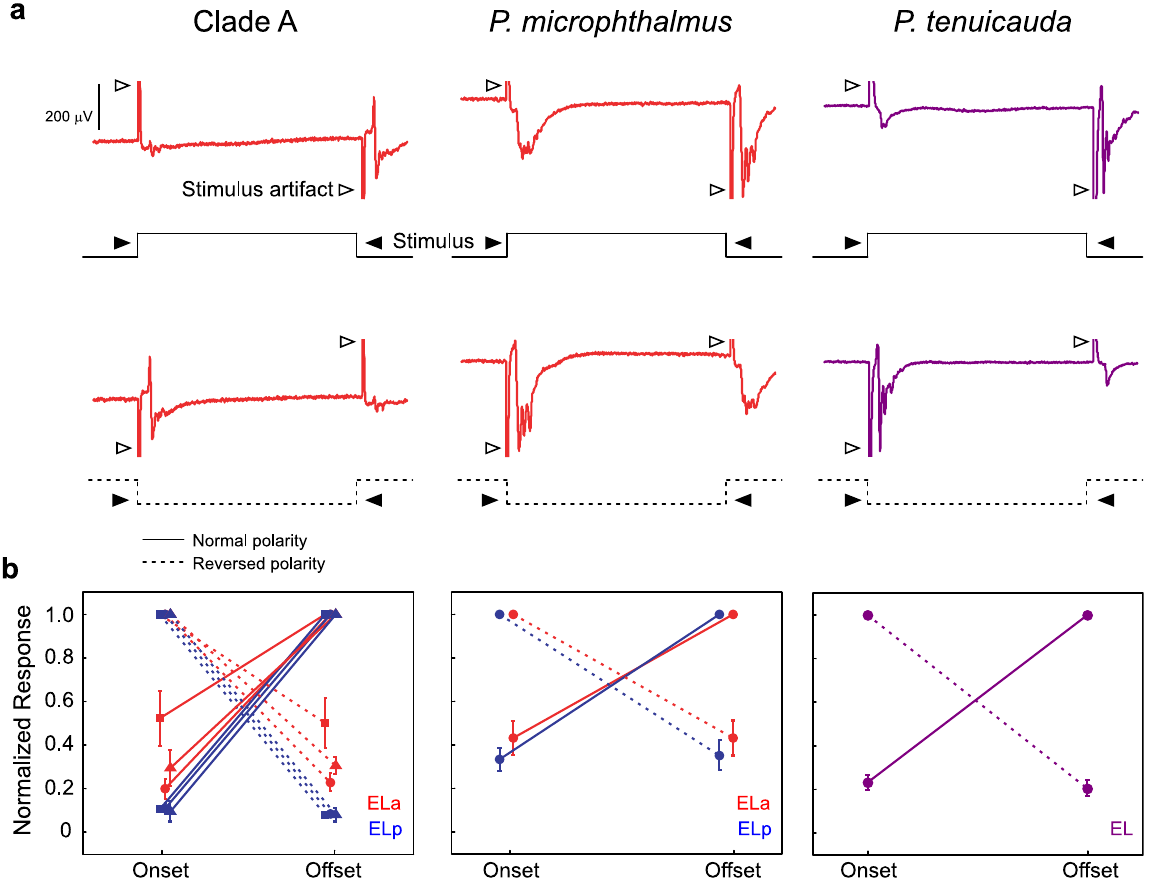
Figure 3. Sensory input to the midbrain is biased towards stimulation of electroreceptors on the contralateral side of the body in all three lineages. ( a ) Representative mean evoked potentials (n = 10 traces) from the left ELa (red traces) of a clade A species ( G . petersii , left) and P . microphthalmus (center), and from the left EL (purple traces) of P . tenuicauda (right) in response to long square pulses delivered with normal polarity (top row, stimulus depicted by full lines) and reversed polarity (bottom row, stimulus depicted by dashed lines). In our experimental set-up (see Methods), the leading edge of a square pulse with normal polarity stimulates knollenorgans on the left side of the body, while the trailing edge stimulates knollenorgans on the right side of the body. The opposite is true for square pulses delivered with reversed polarity. Both traces come from the same subject for each lineage. ( b ) We measured the peak-to-peak amplitude of the evoked potential in response to each edge of the stimulus and normalized them to the maximum value for each fish tested and each stimulus polarity (normal: solid lines, reversed: dashed lines); for clade A and P . microphthalmus , we normalized responses separately for ELa (red symbols) and ELp (blue symbols). The amplitude of the evoked potentials depended on side of stimulation (Clade A: B . brachyistius : n = 2, F 1,7 = 1377.6, p < 0.0001; B . niger : n = 2, F 1, 7 = 304.1, p < 0.0001; G . petersii : n = 3, F 1,14 = 2716.8, p < 0.0001; P . microphthalmus : n = 3, F 1,14 = 322.7, p < 0.0001; P . tenuicauda : n = 7 fish, 10 recordings; F 1,30 = 1390.3, p < 0.0001), but not on order of stimulation (Clade A: B . brachyistius : n = 2, F 1,7 = 0.071, p = 0.80; B . niger : n = 2, F 1, 7 = 0.002, p = 0.97; G . petersii : n = 3, F 1,14 = 0.002, p = 0.96; P . microphthalmus : n = 3, F 1,14 = 0.02, p = 0.88; P . tenuicauda : n = 7 fish, 10 recordings; F 1,30 = 0.45, p = 0.51). Each symbol in ( b ) represents the mean normalized amplitude and the error bars represent the SEM. Clade A species tested include B . brachyistius (squares), B . niger (triangles), and G . petersii